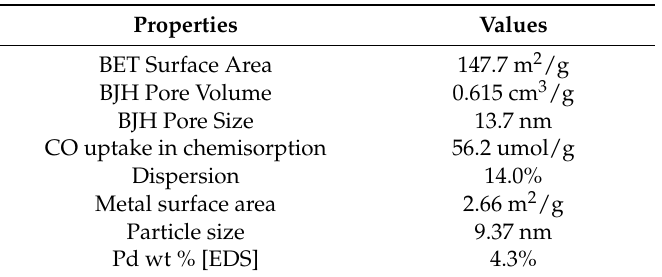
Table 1. Properties of the catalyst.